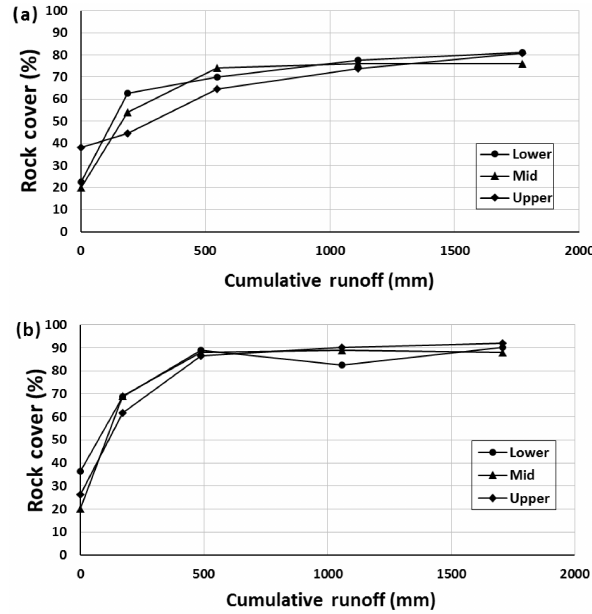
Figure 2. Surface rock cover (>5mm) on the three sections of the plots as a function of cumulative runoff for (a) 5% slope, replication 2, and (b) 12% slope, replication 2.